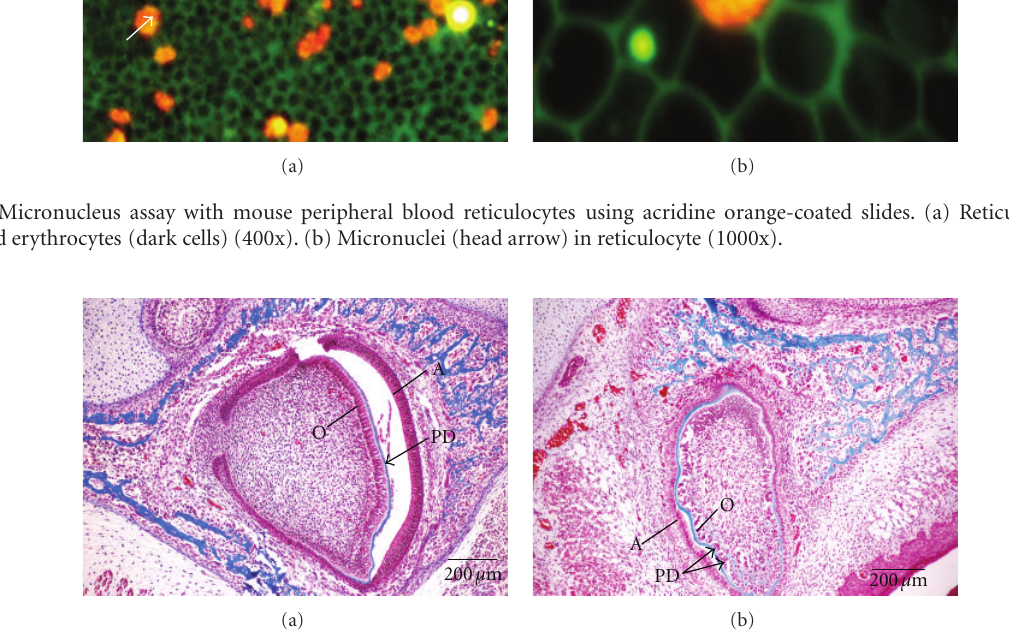
Figure 3: (a) Control dental primordium section from upper incisor with trichrome Masson stain. (A): Ameloblast. (O): Odontoblast. Predentine (PD). (b) Exposed dental primordium section from upper incisor with trichrome Masson stain. (A): Ameloblast. (O): Odontoblast. Predentine (PD).